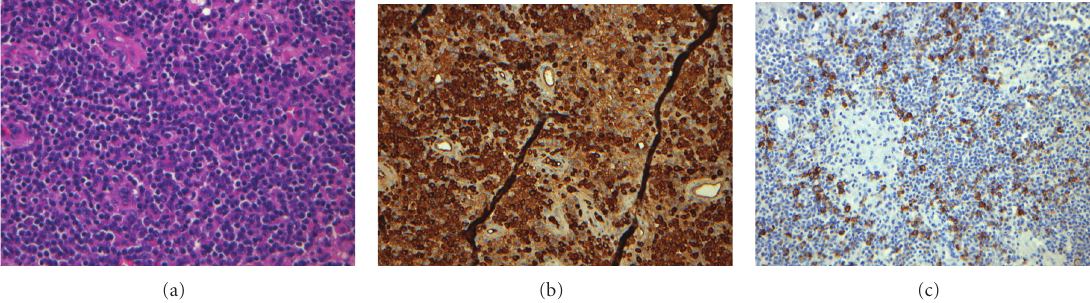
Figure 3: Histological and immunohistochemical analysis of posttransplant EBV-associated plasmacytoma in the CNS. (a) H&E section of a tumor showing a solid infiltrate of atypical malignant plasma cells ( × 40). (b) The plasma cells are positive for lambda light chains by immunophenotyping ( × 20). (c) Immunohistochemistry showing scattered tumor cells positive for EBV ( ×